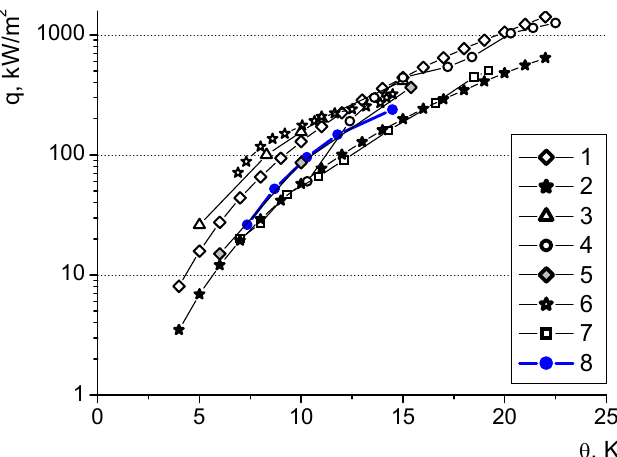
Figure 5. Validation of the experimental method: data for current smooth sample water boiling (8) vs. literature based calculations and raw data. 1, model [31] with constants by [32]; 2, correlation [33]; 3,4,5,6 and 7, horizontal smooth copper surface test results, data adopted from [34], [35], [36], [21] and [20], respectively.